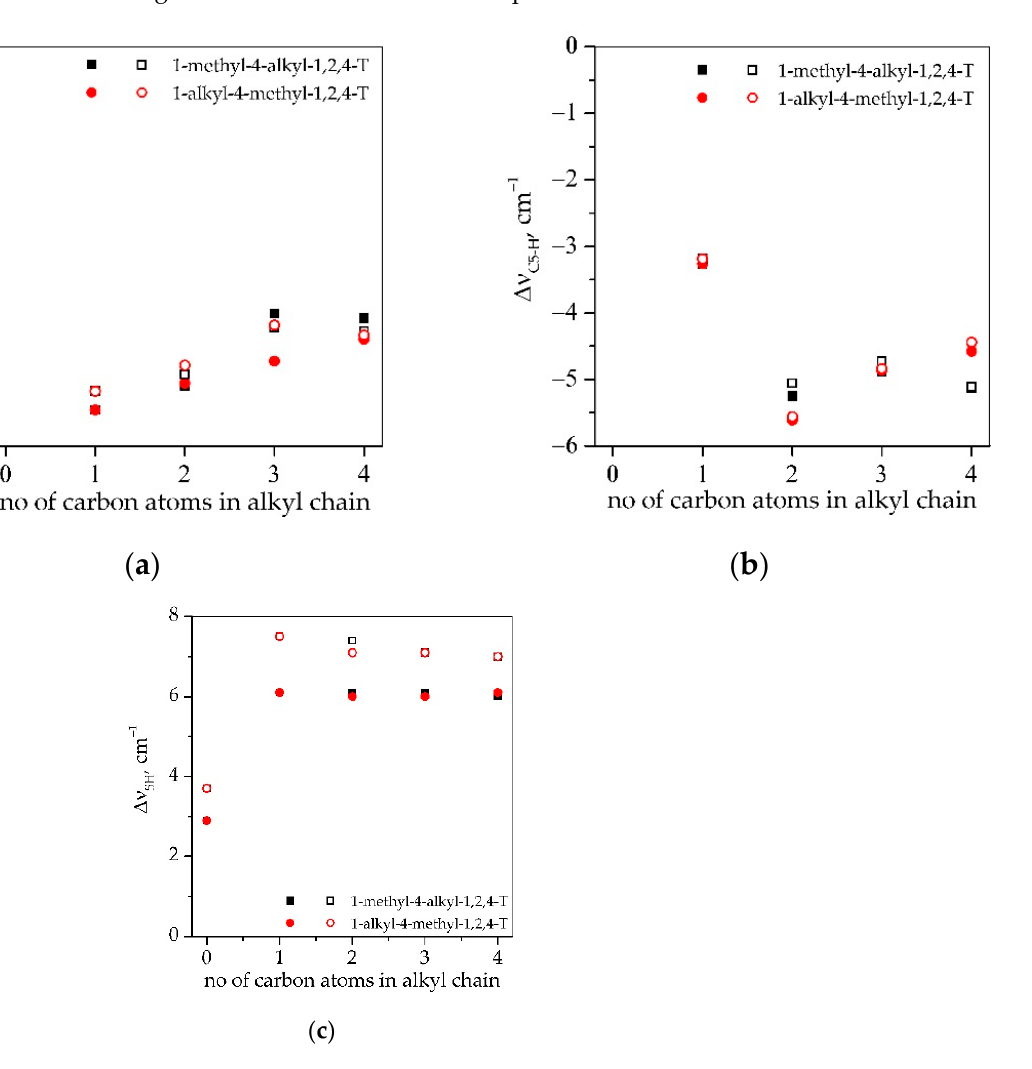
Figure 4. Results of FTIR investigations: shifts in the absorption bands of the ( a ) C3-H ( ∆𝜈 𝐶3-𝐻 ) and ( b ) C5-H ( ∆𝜈 𝐶5-𝐻 ) bonds of 1,2,4-triazole ring of the ionic liquids and ( c ) SH ( ∆𝜈 𝑆𝐻 ) group of the thiols PETMP (filled symbols) and PETMB (open symbols) in four-component systems (thiol–ene–IL–PC).